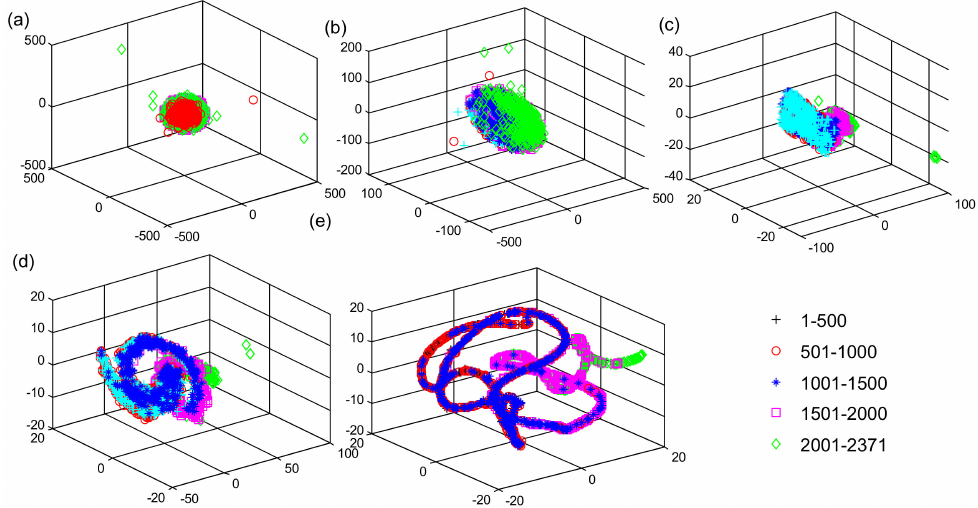
Figure 17. Visualization results of the different layers for the LSTM. ( a ) Network input; ( b ) First LSTM layer; ( c ) Second LSTM layer; ( d ) Third LSTM layer; ( e ) FC2